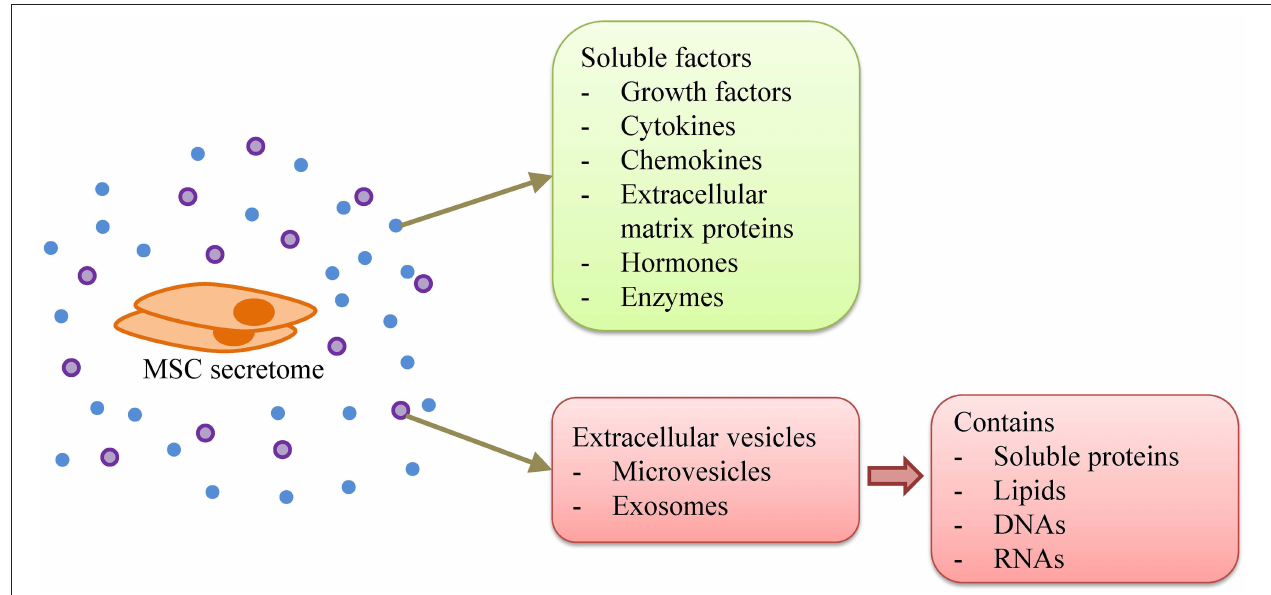
FIGURE 2 | MSC secretome. MSC secretome consists of soluble factors, i.e., growth factors, cytokines, chemokines, extracellular matrix proteins, hormones, and enzymes, as well as extracellular vesicles that contain soluble proteins, lipids, DNAs, and